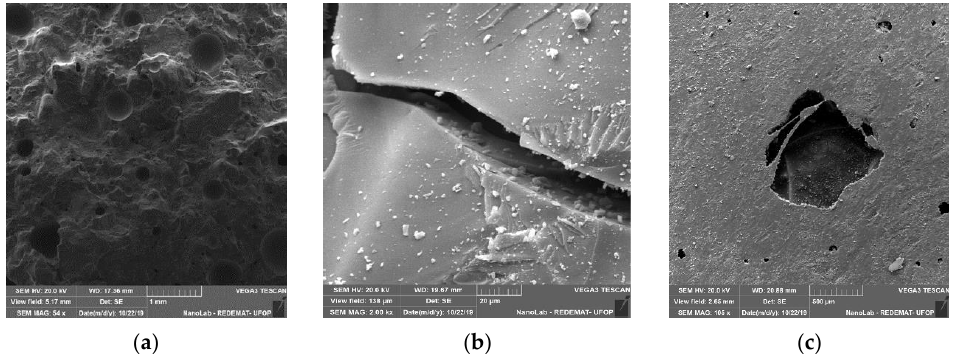
Figure 20. Flexural ( a ) (54 × magnification), ( b ) (2000 × magnification) and lateral ( c ) (105 × magnification) surface of the matrix of epoxy resin and carbon fibre.